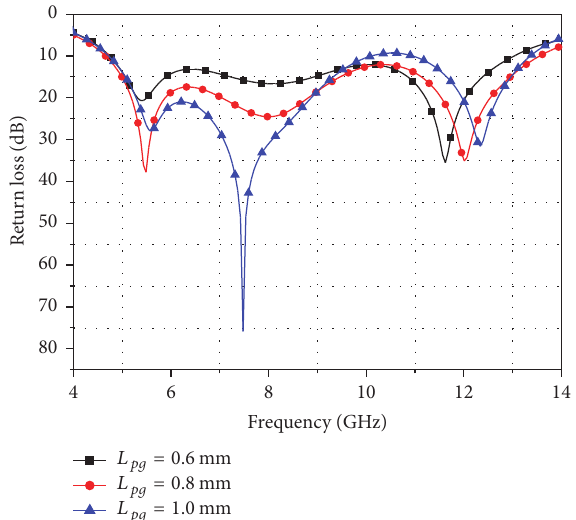
Figure 10: Simulated return loss against frequency for the proposed defected substrate wideband antenna with various 𝑊 𝑝1 ; other parameters are the same as listed in Table 1.